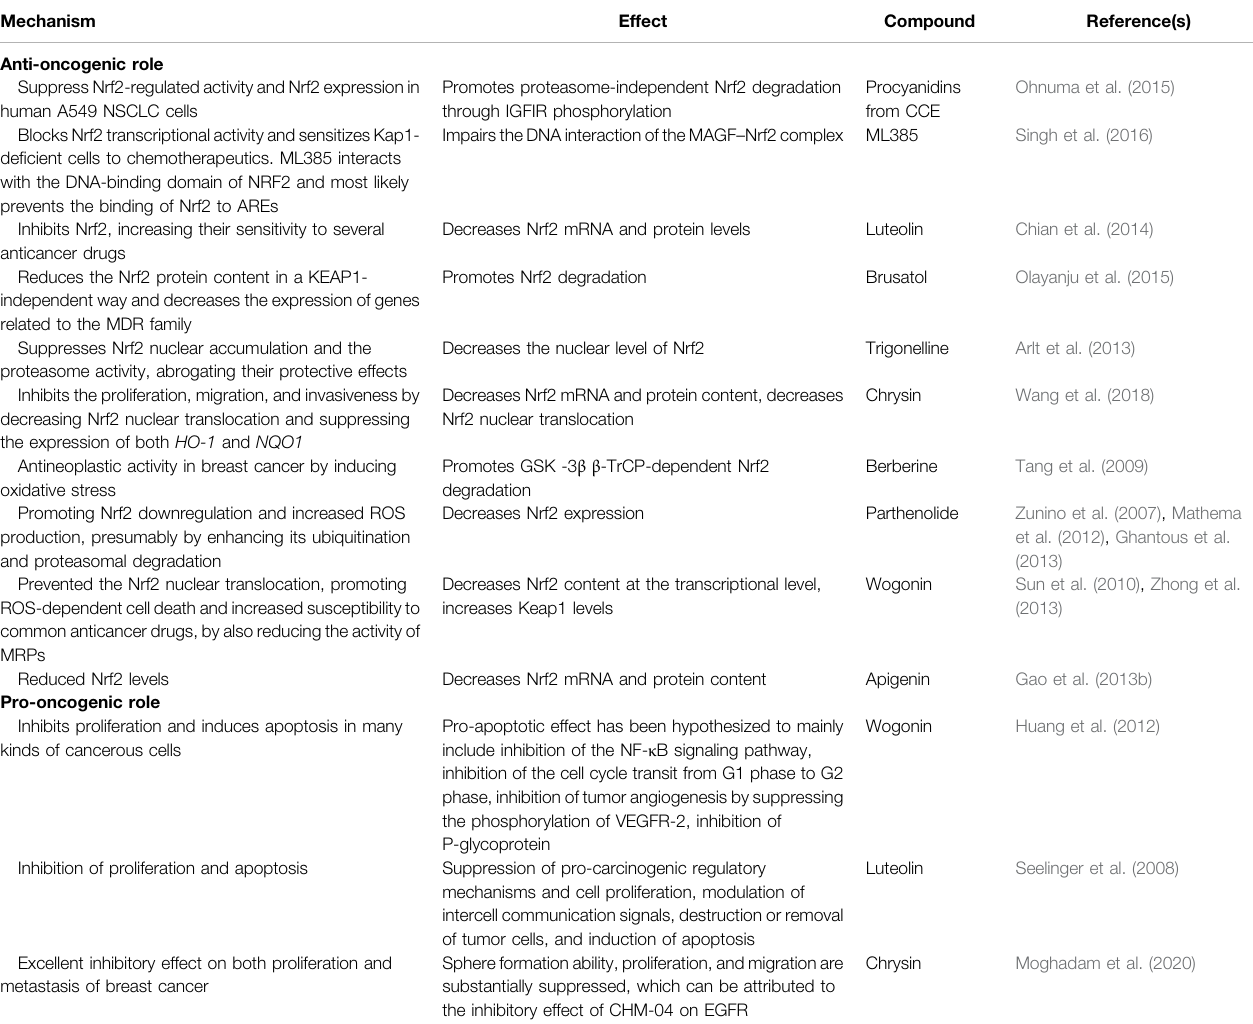
TABLE 1 | Anti-oncogenic and pro-oncogenic mechanisms of Nrf2 with various compounds: in vitro studies.